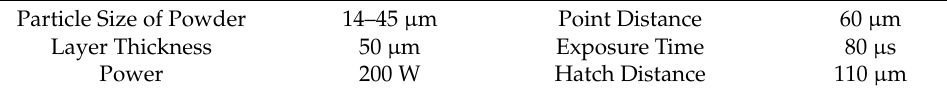
Table 1. Selective Laser Melting process parameters.